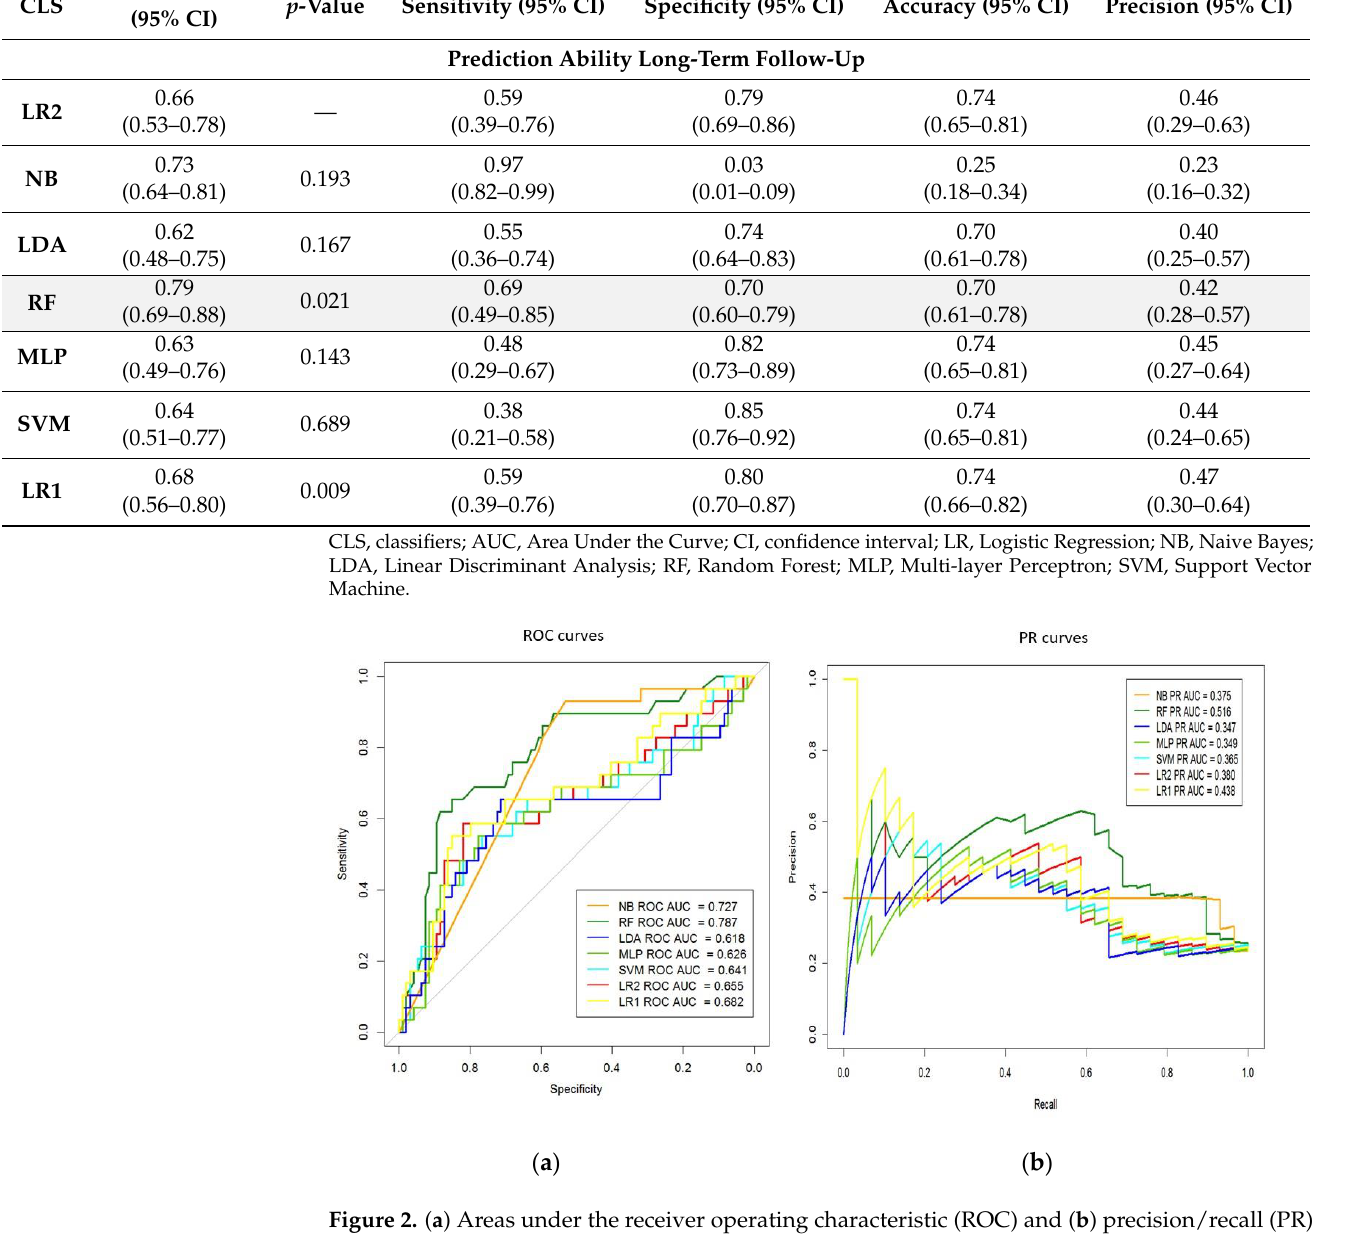
Table 2. Prediction Ability of the Reference Model (LR2, Linear Regression2) and five Machine Learning Models, measured in terms of AUC-ROC, Sensitivity, Specificity, Accuracy, and Precision values to predict MACE, using 8-fold cross-validation of 123 patients from the testing dataset.